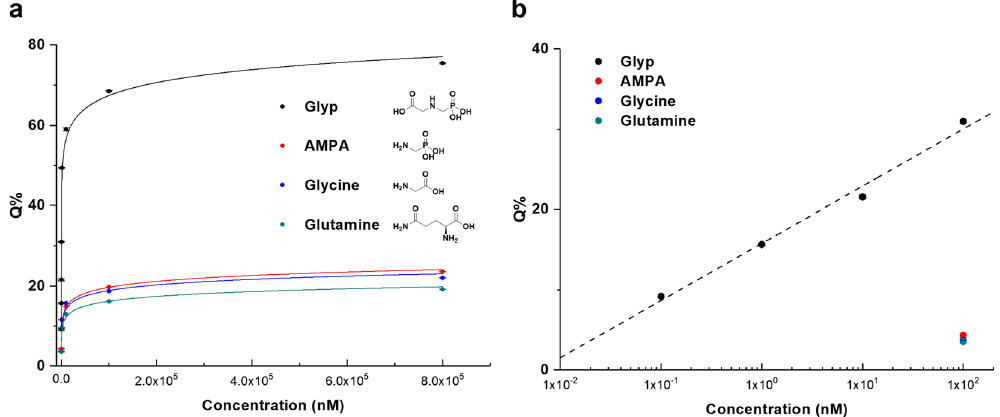
Figure 4. Concentration dependence of the degree of fluorescence quenching ( Q %) on MIMO-zQ: ( a ) the whole concentration region and ( b ) the low concentration region in the logarithm scale. Each color line shows the estimated fits for different kinds of analyte (the target is glyphosate). The black dotted line indicates the logarithmic linearity between glyphosate and MIMO-zQ. All measurements were performed at five different